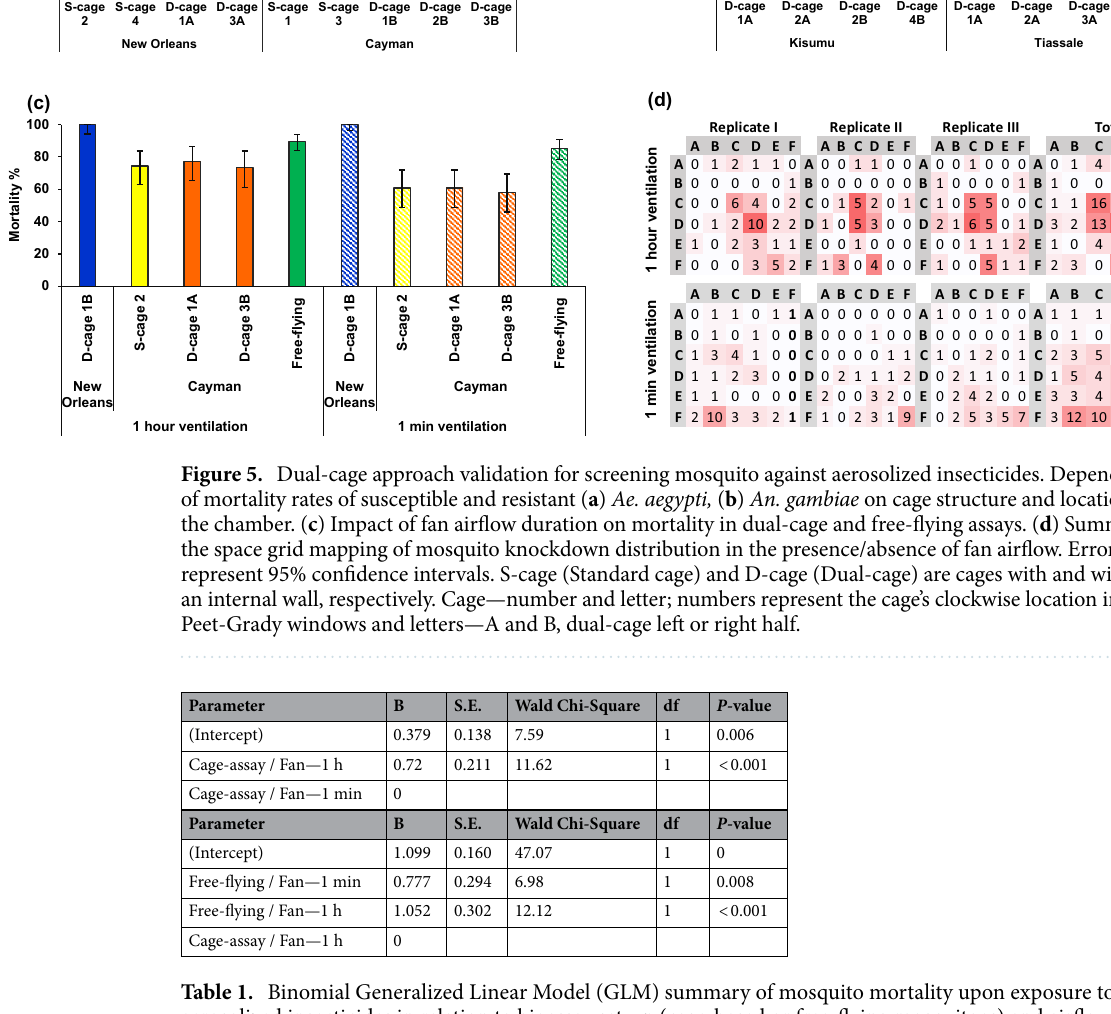
insecticide droplets (Fig. 4a–c). The steady knockdown rate for the Ae. aegypti resistant colony against each aerosol tested (Fig. 4a,b) beginning approximately 15 min after aerosol deployment suggests that neither mos- quito contact with insecticide on the cage’s walls or circulation of residual droplets have a substantial impact on accumulation of knocked-down mosquitoes in the resistant strain over the 1 h-exposure period. Dual-cage assay validation. Our results based on the Aedes Cayman resistant strain revealed that an uneven fan set-up could impact aerosol bioassay reproducibility (Fig. 4a), such as for average knockdown rate ( χ 2 = 4.875, P = 0.03, df = 1), presumably due to heterogeneous insecticide droplet dispersion. However, this was readily corrected using a spirit level for fan horizontal orientation, following which there was no significant difference ( χ 2 = 4.671, P = 0.700, df = 7) in mortality between cage halves or among cages positioned next to the different observation windows (Figs. 4b,c and 5a,b). Thus, fan calibration is essential for even aerosol dispersion and resultant assay reproducibility.